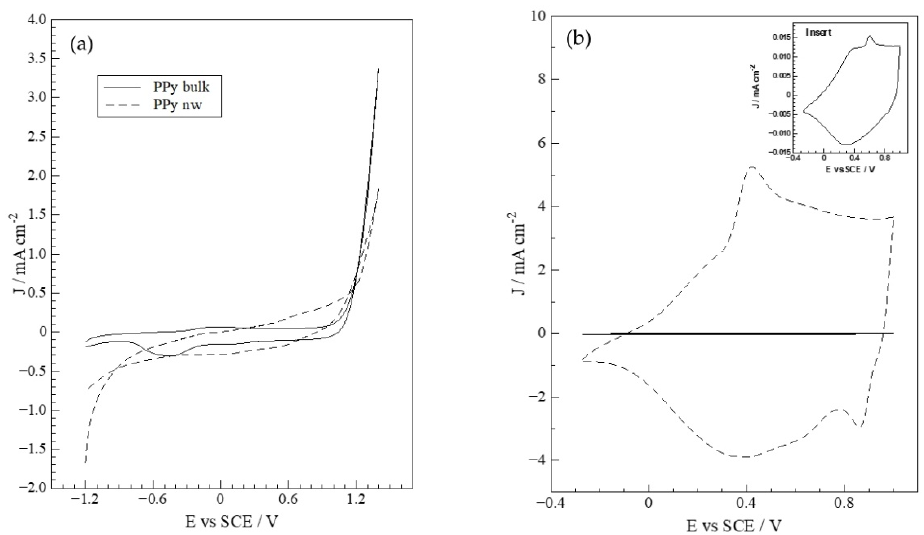
Figure 1. ( a ) Cyclic voltammograms during growth of PPy on modified ITO electrodes|polymer in: (––) absence of template, and ( ‐ ‐ ‐ ) template presence. ( b ) p ‐ doping/undoping study in 0.100 mol L − 1 (—-) absence of template, and (- - -) template presence. ( b ) p -doping/undoping study in 0.100 mol TBAPF 6 , CH 3 CN of ITO modified with: (––) bulk PPy, ( ‐ ‐ ‐ ) PPy ‐ nw. ν = 0.100 V s − 1 . Insert: zoom of L − 1 TBAPF 6 , CH 3 CN of ITO modified with: (—-) bulk PPy, (- - -) PPy-nw. ν = 0.100 V s − 1 . Insert: PPy bulk p ‐ doping/undoping study. zoom of PPy bulk p -doping/undoping